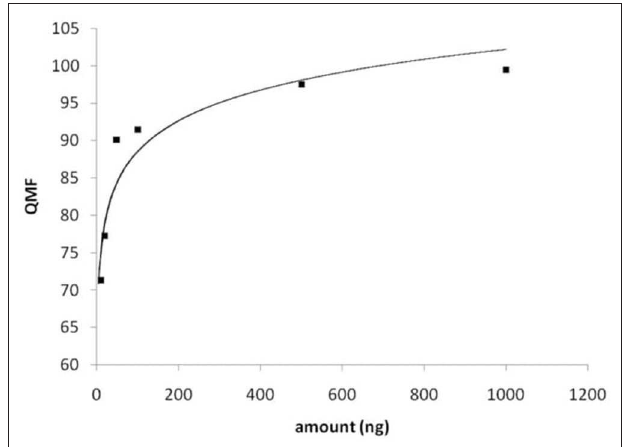
FIGURE 4 | Plot of the QMF values obtained for library search of JWH-018, as a function of the amount measured.